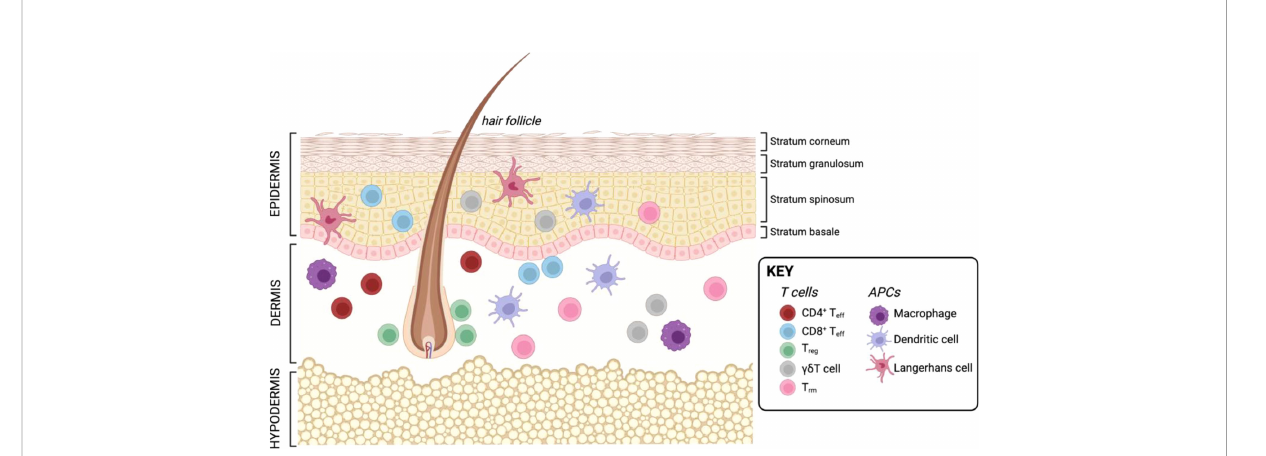
FIGURE 3 Resident T cells and APCs in the human skin. Created with